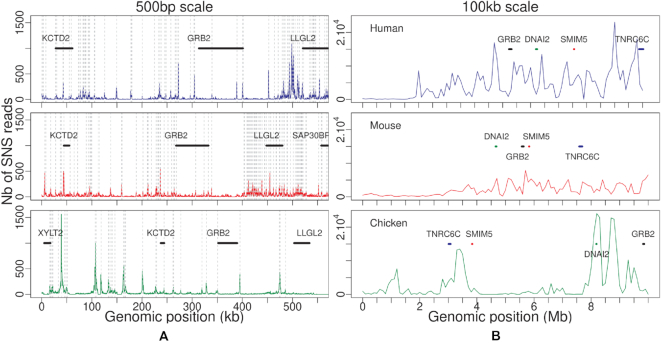
Profile of replication initiation activity along a representative homologous locus in human (top), mouse (middle) and chicken (bottom) genomes. (A) Number of SNS reads per 500 bp window in human chr17:73 000 600–73 550 600, mouse chr11:115 376 000–115 926 000, and chicken chr18:10 486 119–11 036 119 regions. (B) Number of SNS reads in 100 kb windows in a 10 Mb region centred on the region presented in (A). Vertical grey dotted lines represent detected origins, and several homologous genes are annotated with thick lines.